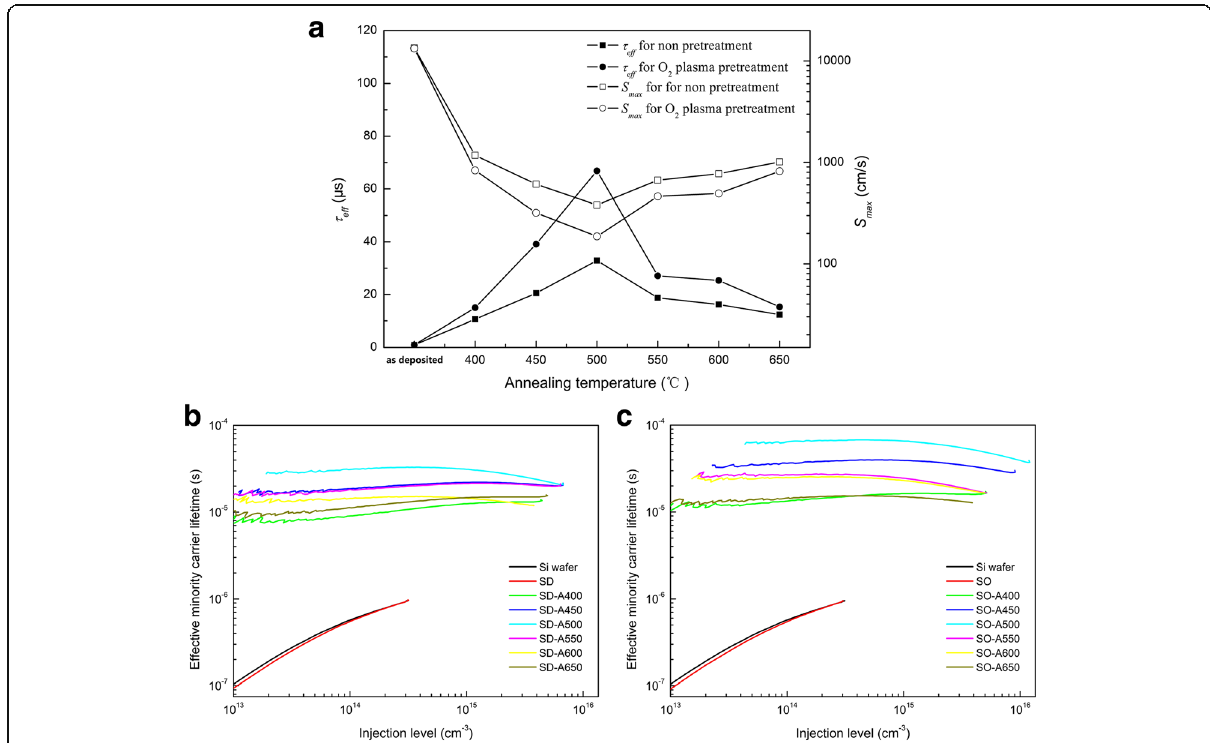
Fig. 1 a τ eff and S max of the samples at the injection level of 3×10 14 cm − 3 . Injection level-dependent effective minority carrier lifetime of the ( b ) SD and ( c ) SO